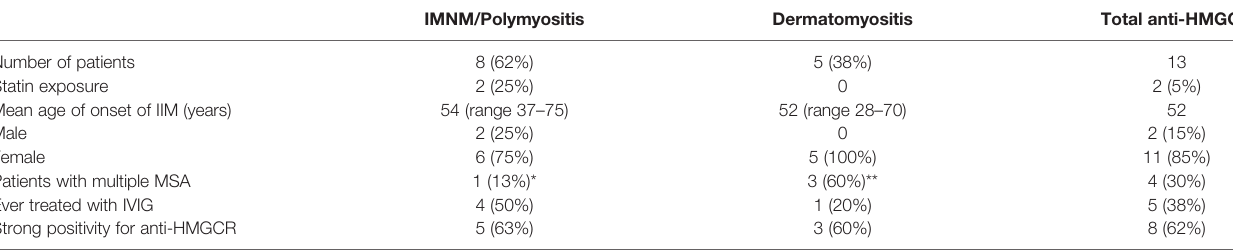
TABLE 2 | Comparison of anti-HMGCR – positive patients with phenotype of polymyositis and